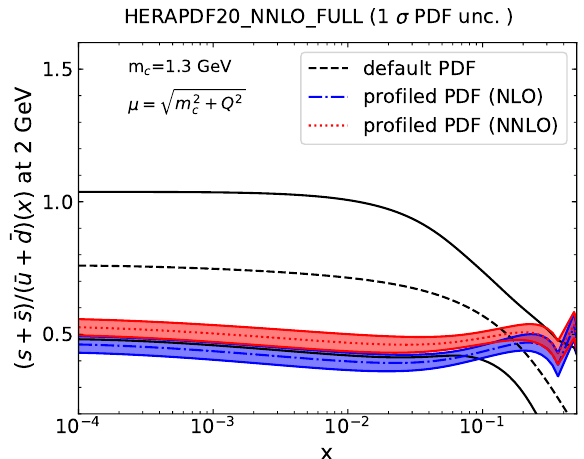
Figure 11 . PDF ratio of strange to non-strange sea-quarks at 2 GeV as a function of x for the HERAPDF2.0 NNLO PDFs. The solid black lines indicate the upper/lower uncertainties of original PDFs. The colored bands represent the central value and uncertainty after pro(cid:12)ling using the NuTeV and CCFR charm (anti-)quark production data with the NLO and NNLO predictions.